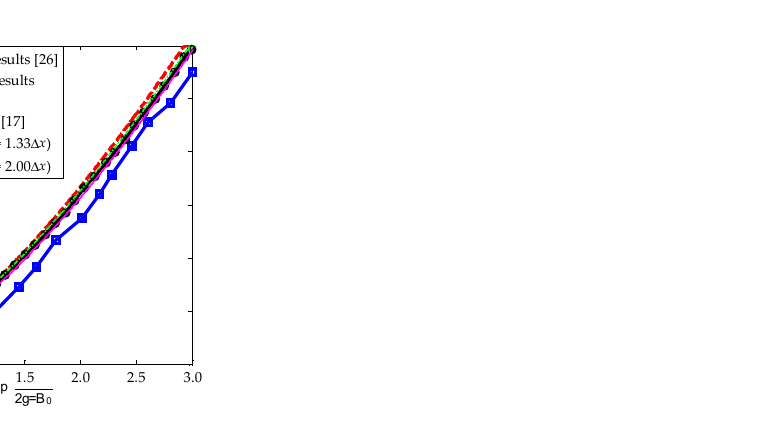
Figure 14. Comparison of the dimensionless height of the water column near the left wall ( 0.025 m) x Δ = .